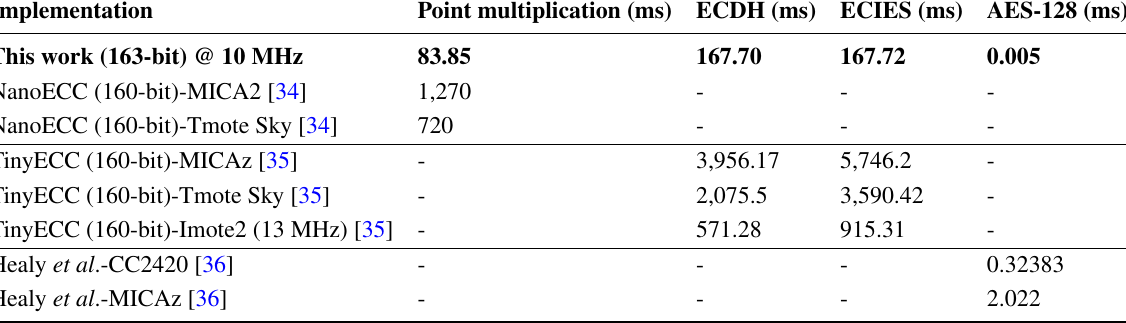
Table 9. Comparison on execution time (ms) with other Elliptic Curve Cryptography (ECC) and AES-128 implementations in commercial sensor nodes (B-163).